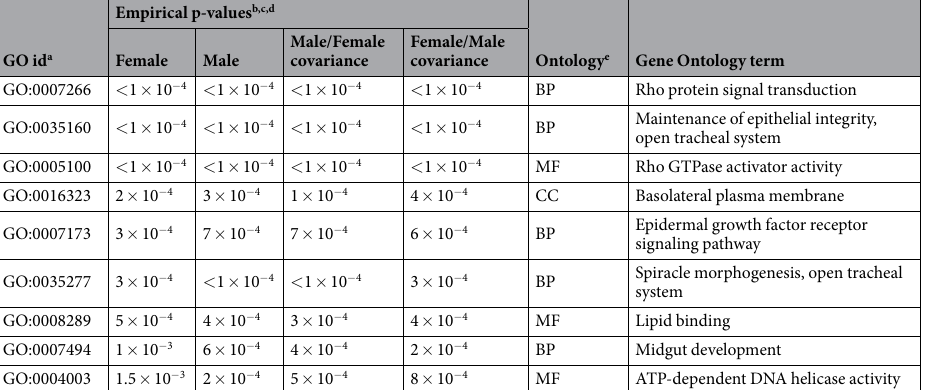
Table 1. Gene ontology terms significantly associated with CCRT for males and females. a GO id = gene ontology id. b p-values smaller than or equal to 0.001 were included for each sex. c The empirical distributions were obtained by randomly sampling from gene regions on the genome. d 10,000 permutations were performed for each GO term. For p-values less than 1 × 10 − 4 , more permutations would yield more precise p-values. e BP = Biological Process, MF = Molecular Function and CC = Cellular Component.